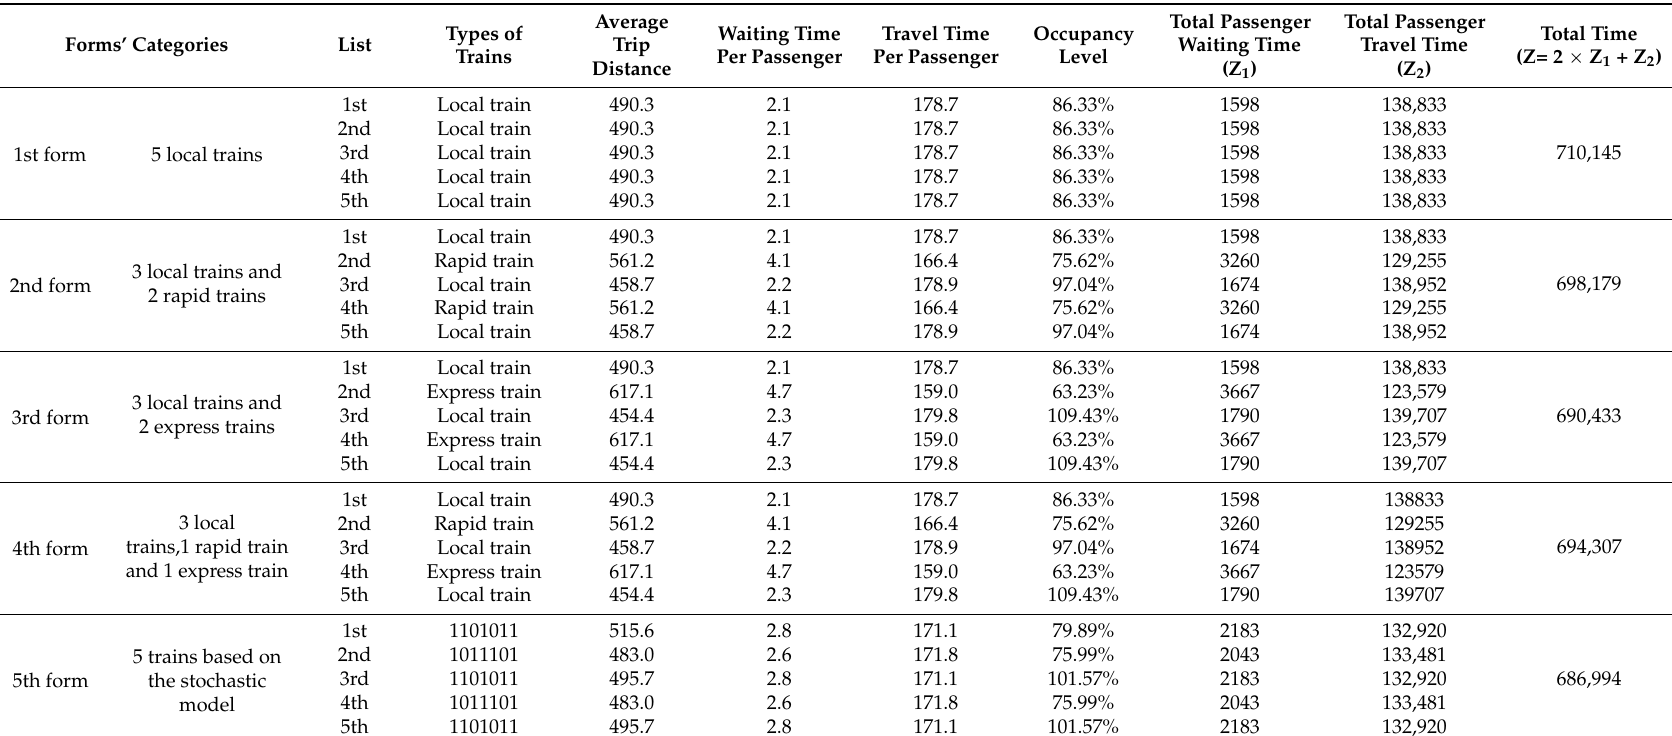
Table 4. Results of five forms (unit: min).